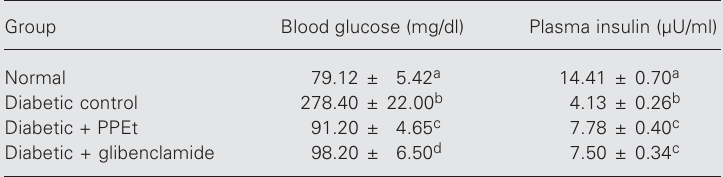
Table 1. Effect of Phaseolus vulgaris pod extract (PPEt) on blood glucose and plasma insulin levels in normal and diabetic rats.